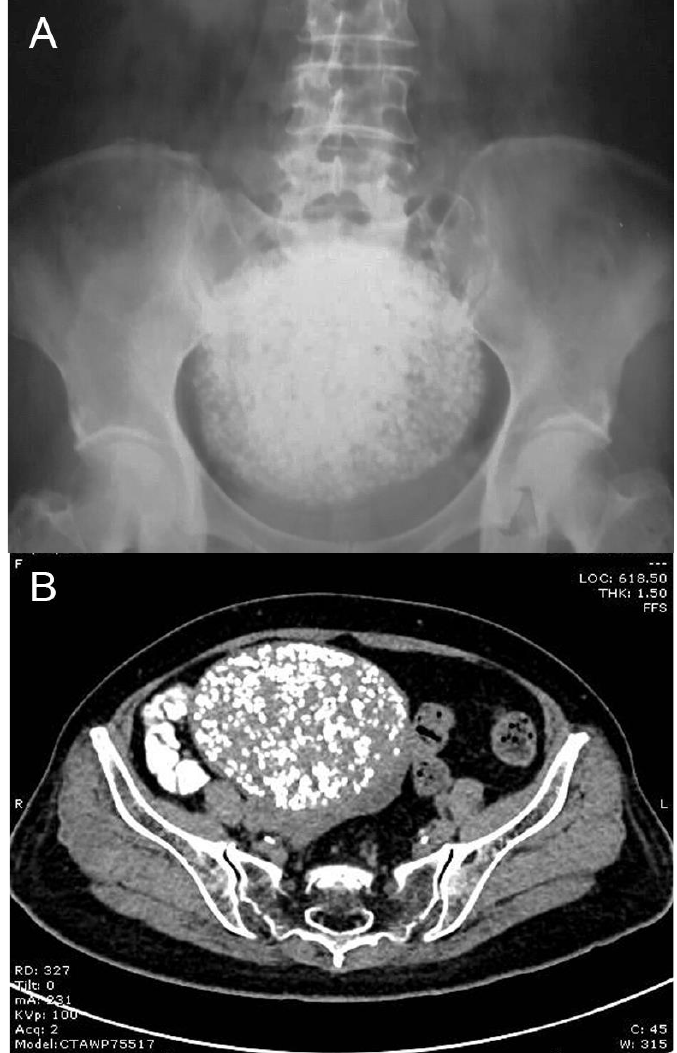
Figure 1. A 66-year-old nulliparous, postmenopausal Thai woman presented with lower back